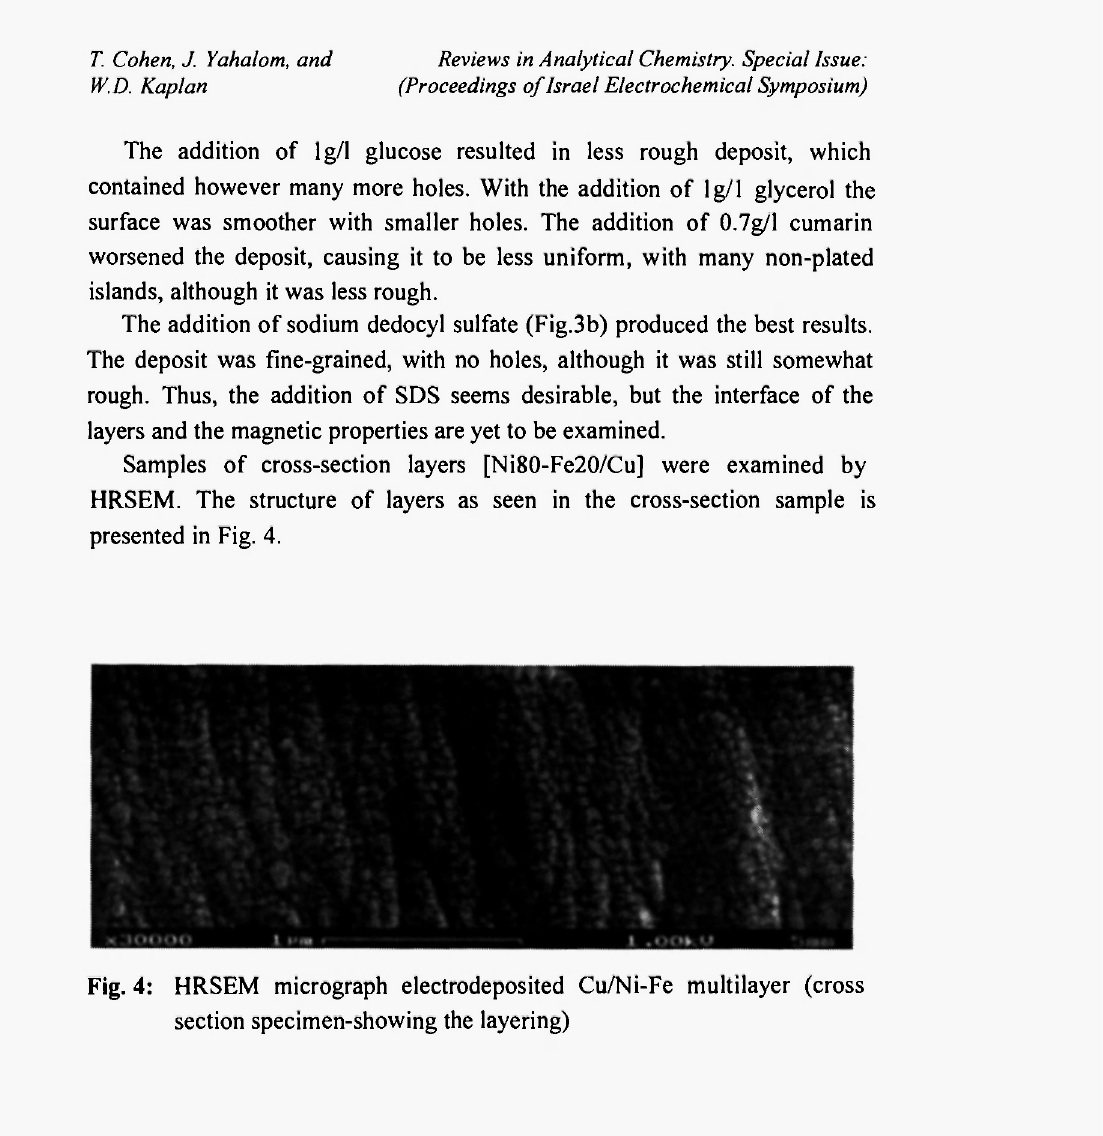
Fig. 4: HRSEM micrograph electrodeposited Cu/Ni-Fe multilayer (cross section specimen-showing the